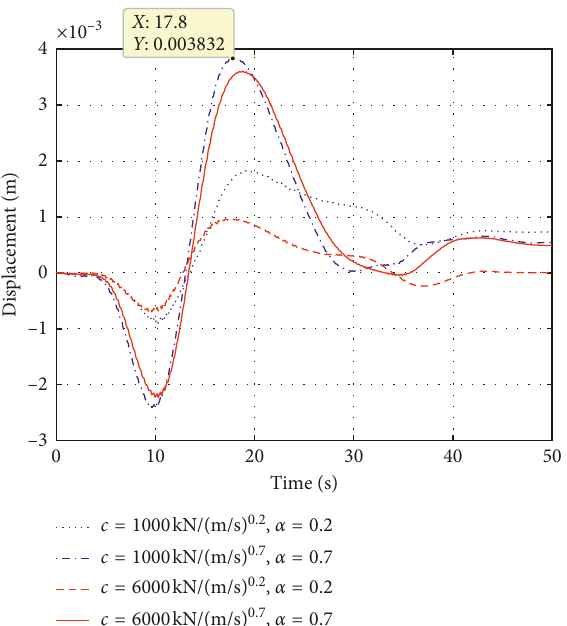
Figure 22: Viscous damper damping